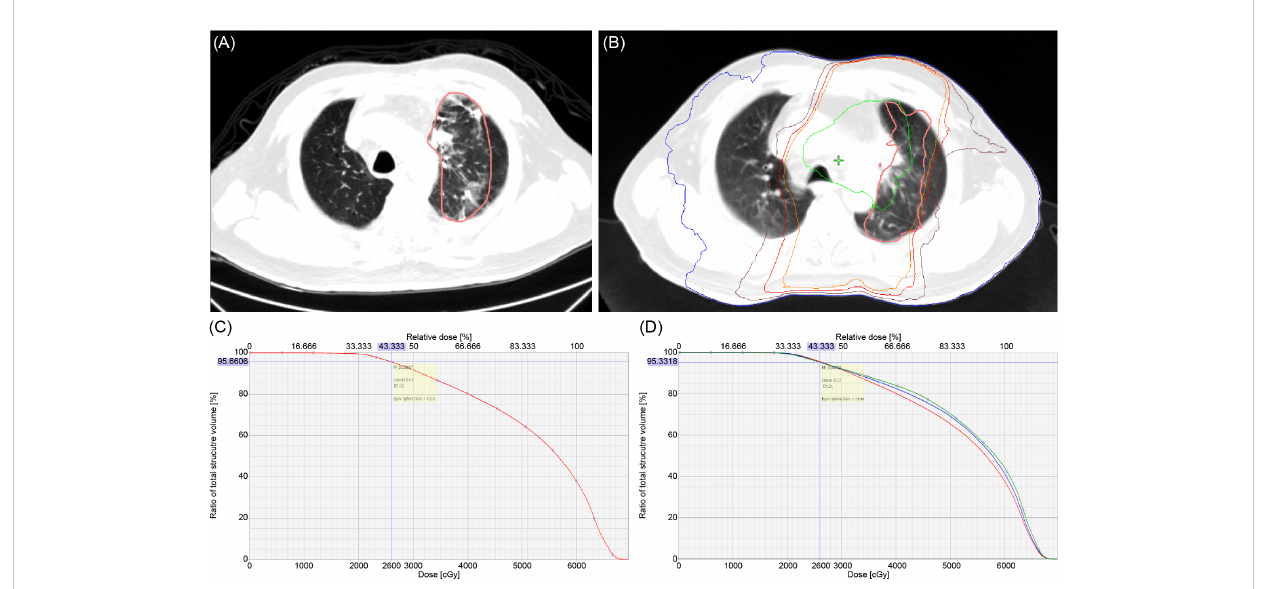
FIGURE 4 (A) RP lesion. (B) RP lesion covered by different isodose curve: blue – 5 Gy, brown – 20 Gy, red – 26 Gy, orange – 30 Gy, green – 60 Gy; pink – RP fi eld projected to planning CT. (C) Demonstrated volume of RP 1 lesion covered by 26 Gy equal to 95.66%. (D) The percentages of RP1, 2, and 3 coverage drop rapidly when it exceeds 26 Gy (red: RP1, blue: RP2, green: